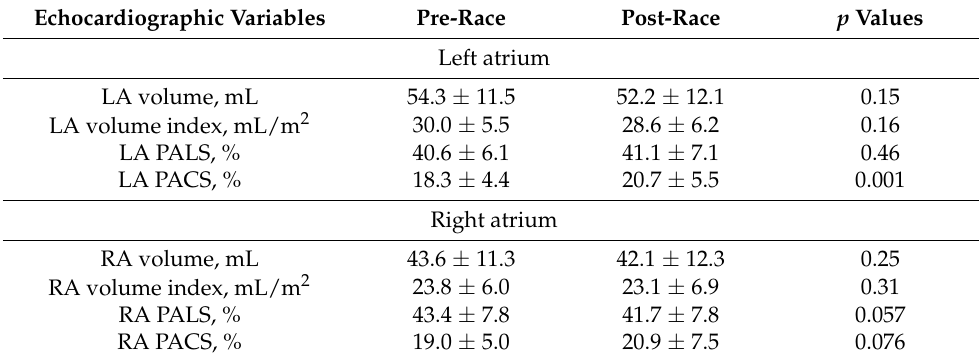
Table 4. Echocardiographic characteristics of the left and right atrium observed before and after the race in master athletes running an